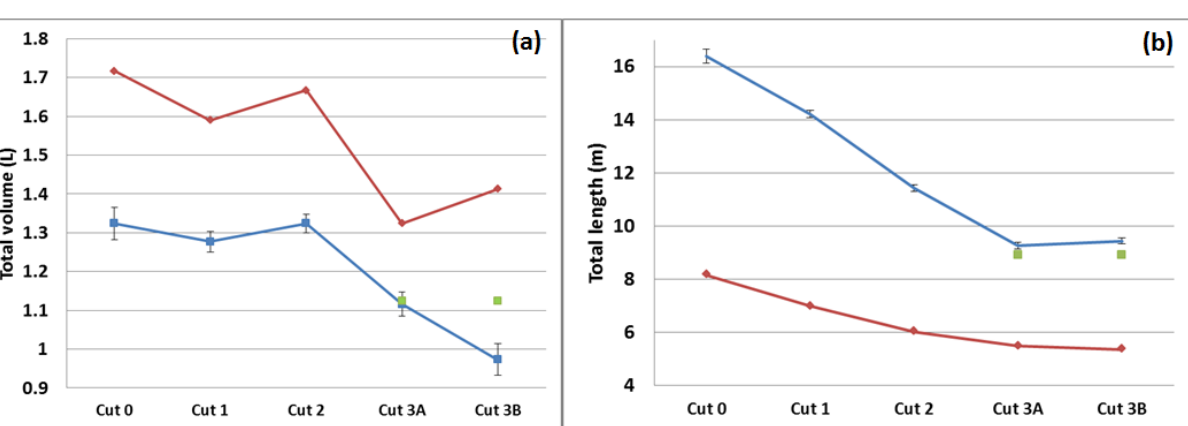
Figure 5. Comparison of the QSM (blue) and TIN (red) models of: ( a ) The total volume. The decreasing trend has not been reproduced in cut 2 by either of the models; ( b ) The total length. The QSM standard deviations are presented as error bars. Reference measurements for total volume and length, plotted with green symbols, only exist for cut